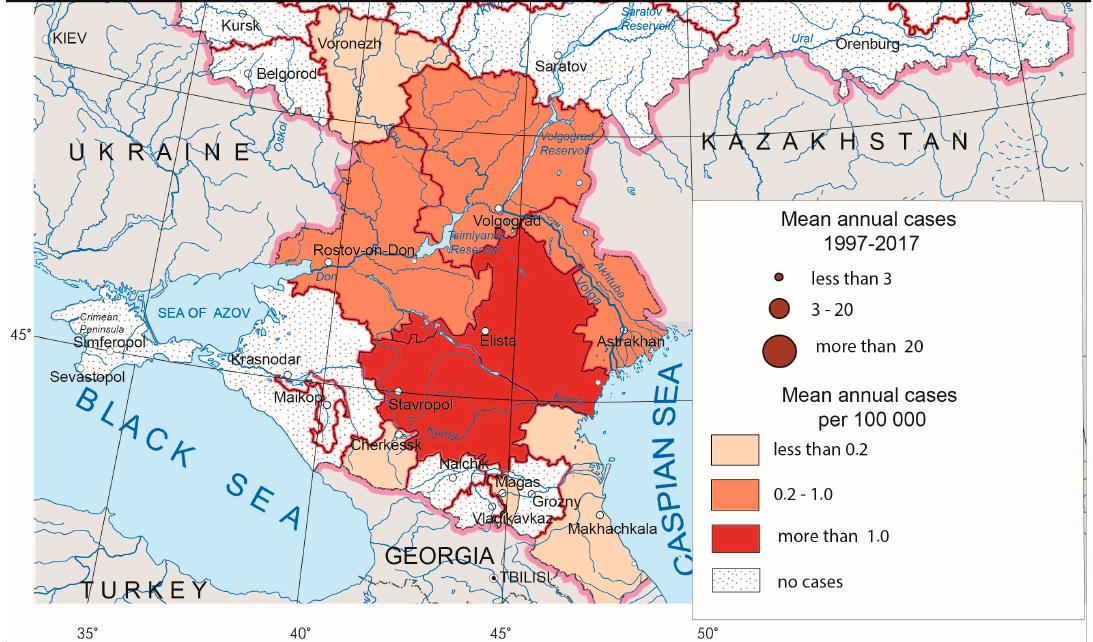
Figure 3. Crimean–Congo hemorrhagic fever morbidity in Russia,